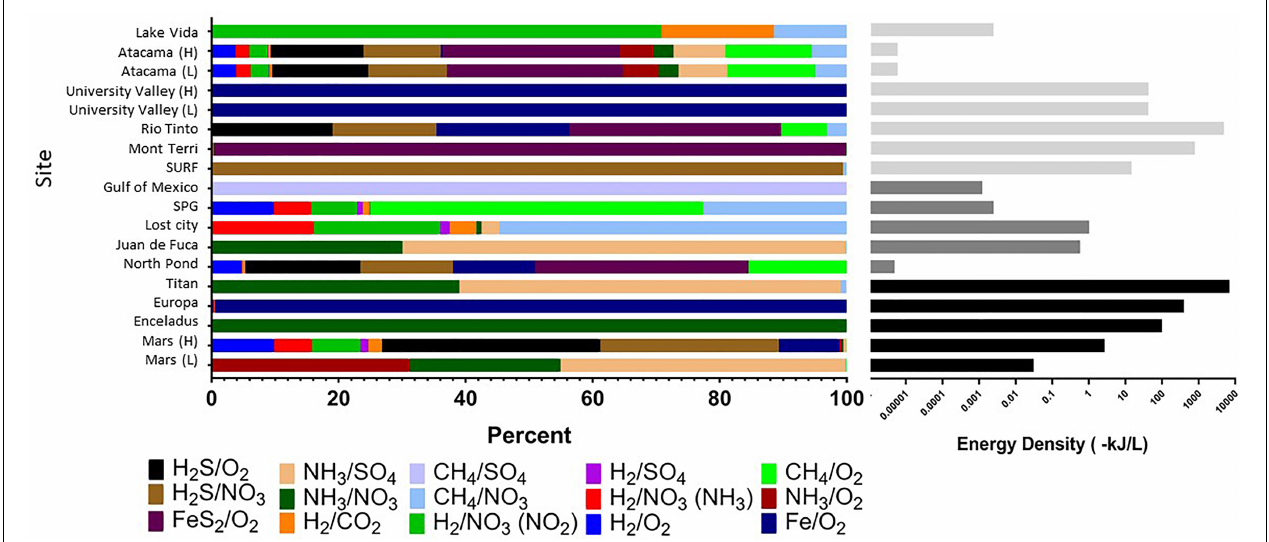
FIGURE 4 | Cumulative volumetric energy densities of redox reactions per site based on environmental concentrations of variables in each reaction ( Table 1 ). (Left) Shows the percent contribution of various reactions as shown in the color legend. (Right) Shows combined absolute energy density (as kJ per liter) for all reactions, with gray scale reflecting habitat type. All calculations assumed that the electron donor was the limiting substrate. See Supplementary Table S1 for all values and